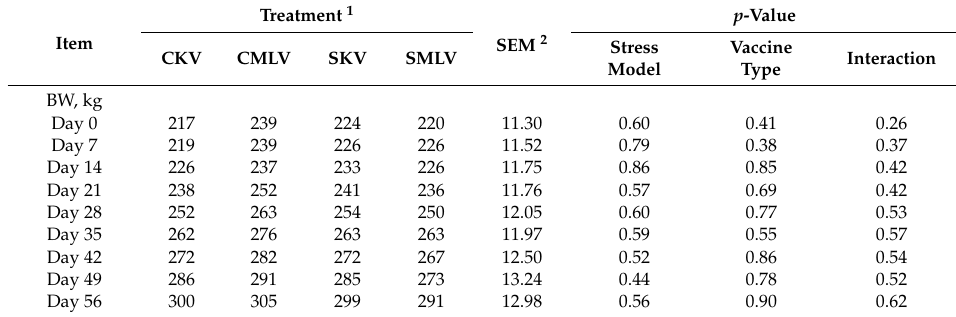
Table 2. E ff ect of stress model and killed or modified-live virus vaccination on body weight of beef